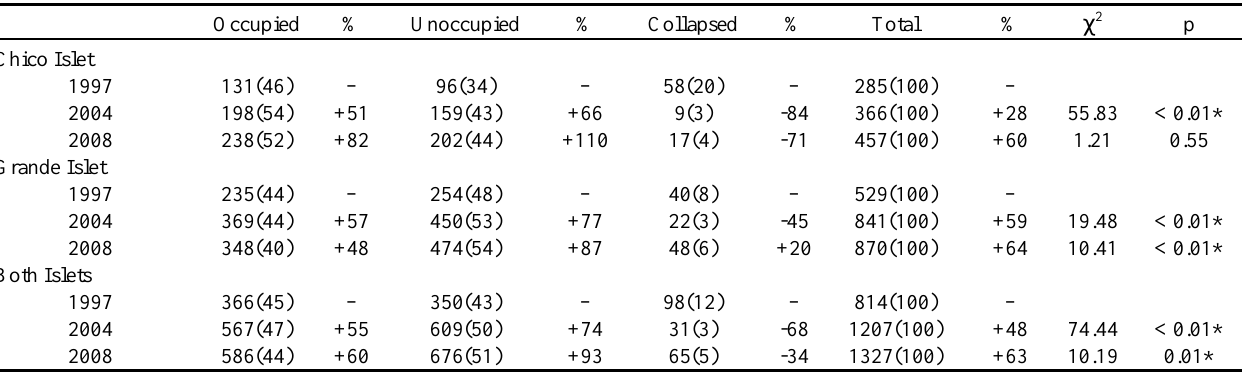
Table 1 . Observed frequencies, chi-square test, and p-values for 2 × 3 contingency tables (df = 2) for 1997-2004 and 2004-2008 reveal changes in the proportion of occupied, unoccupied, and collapsed burrows between the census of the mixed colony of penguins in Puñihuil Islets, Chiloé, Chile. Percentages were calculated based on data from 1997. Proportions of all burrows counted for particular years and islets are indicated in parentheses. Significant values are highlighted by an asterisk (*). Data for 1997 was taken from Simeone and Schlatter